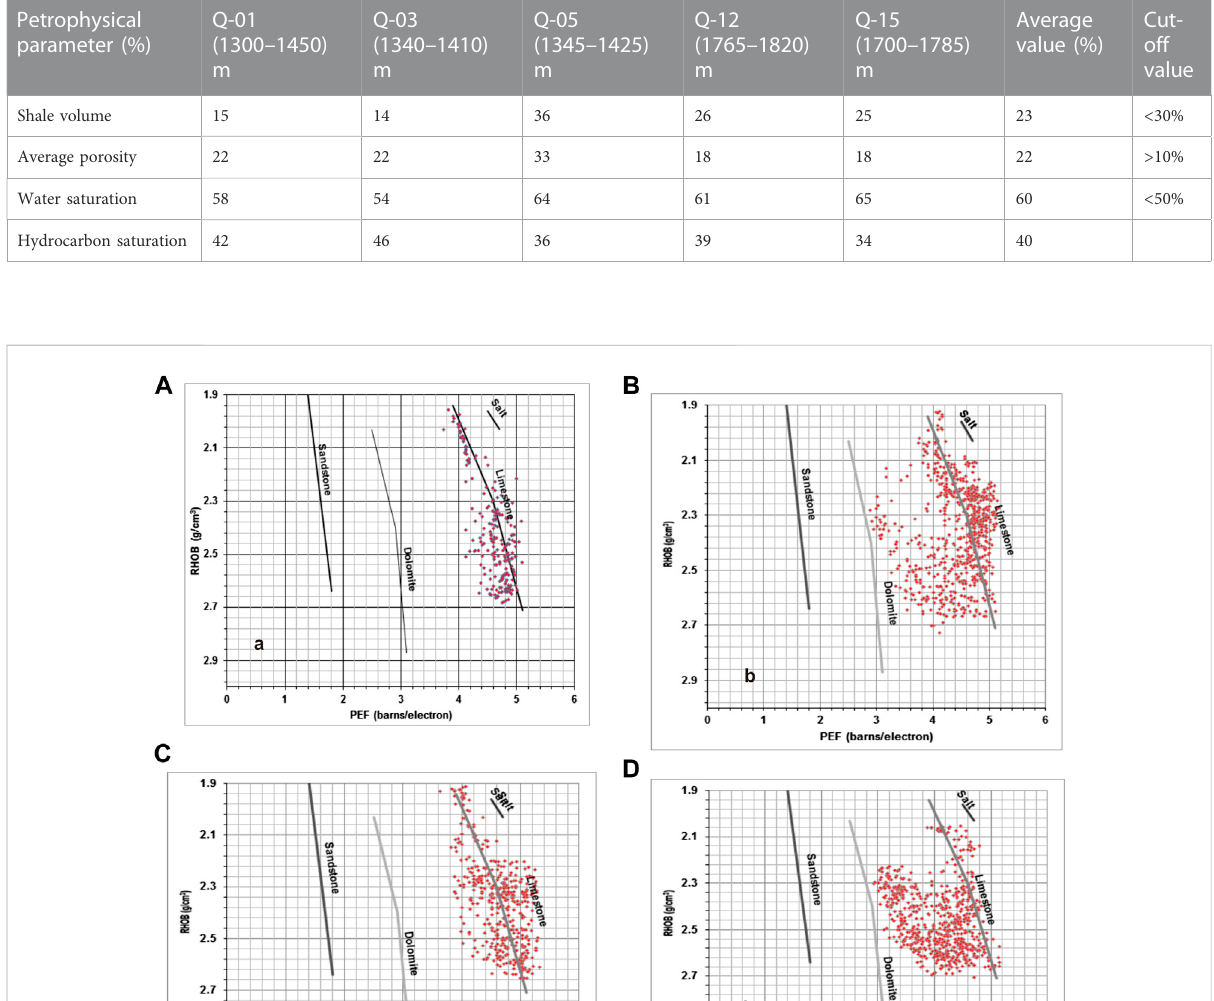
Frontiers in Earth